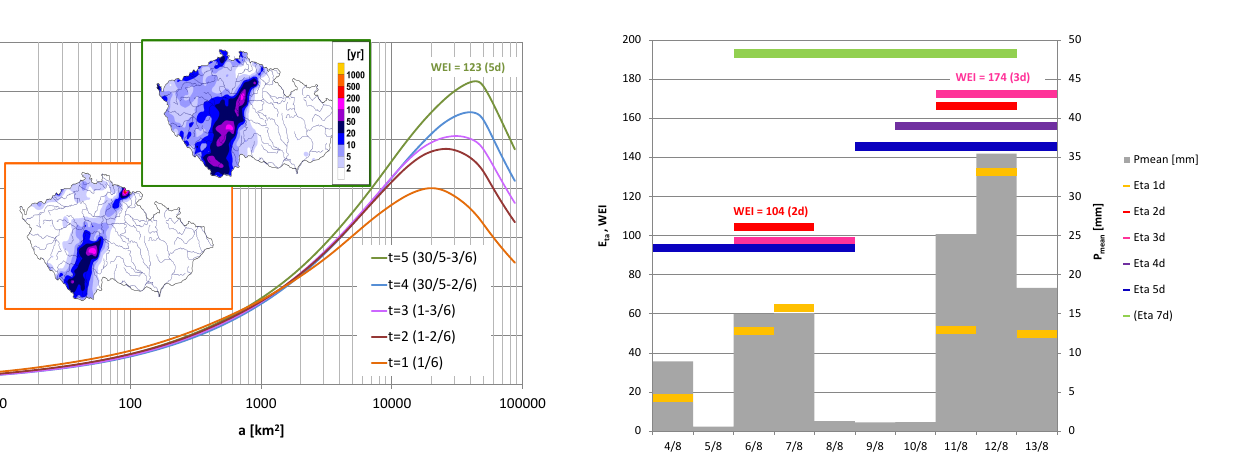
Figure 1. Determination of the WEI of the EPE in May–June 2013 by maximizing E t a . The inset maps present interpolated return pe- riods of 1-day totals on 1 June (left) and of 5-day totals from 30 May to 3 June (right).